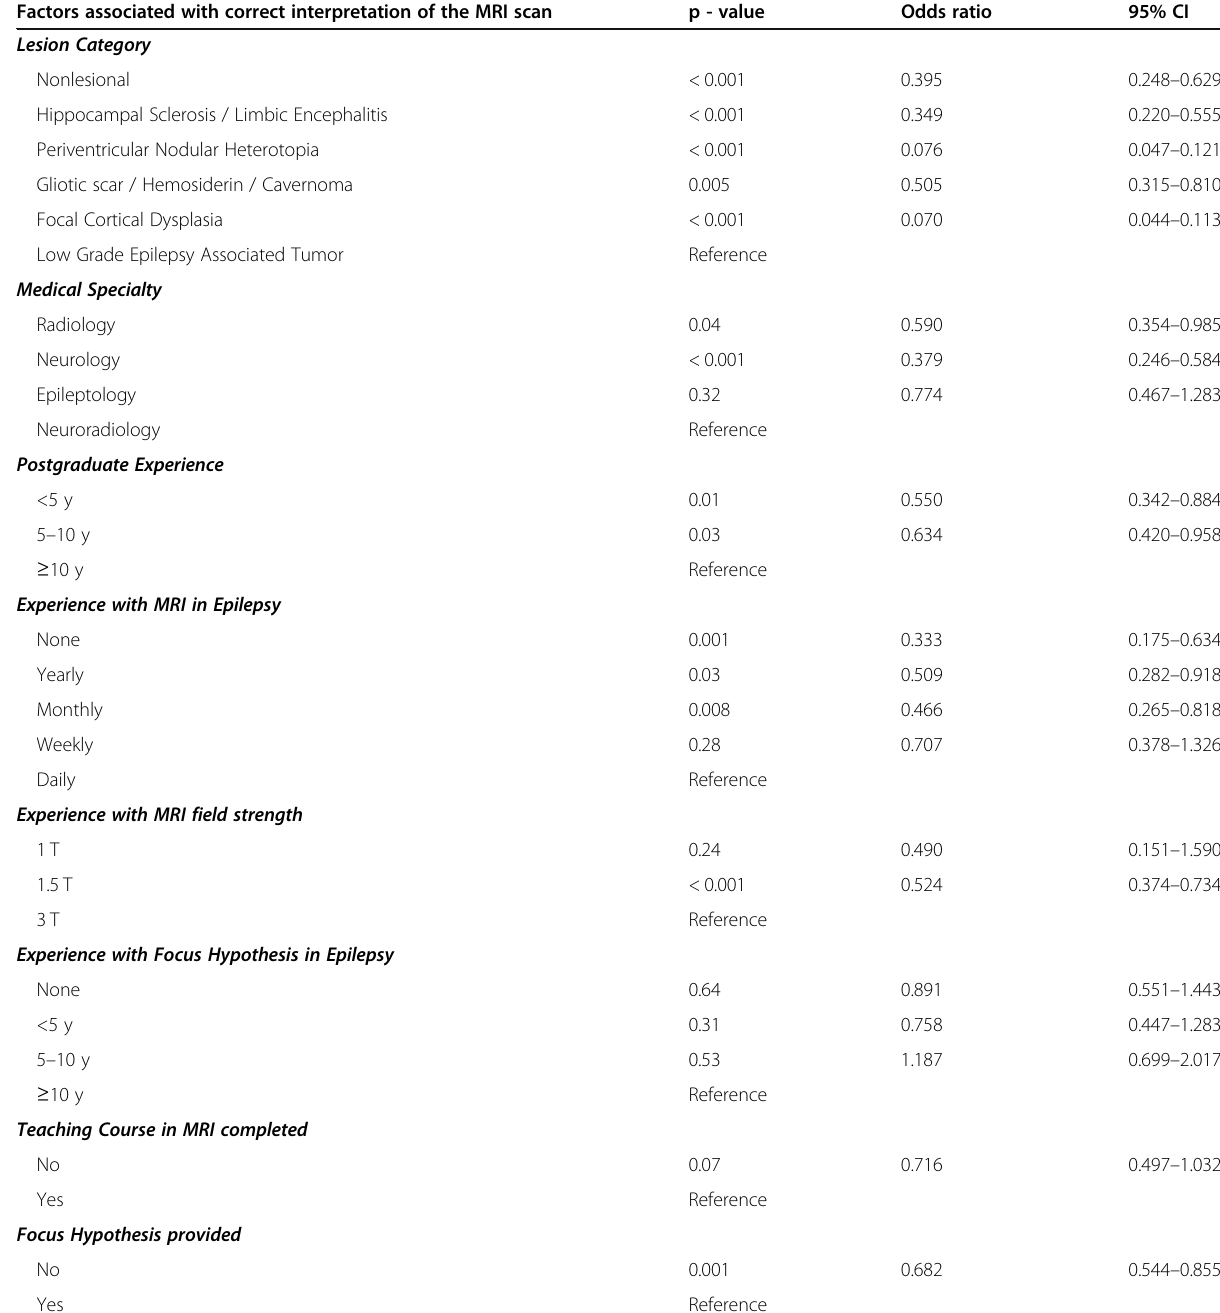
Table 3 Univariable binary logistic regression analysis, based on generalized linear mixed - effects model, entire dataset Factors associated with correct interpretation of the MRI